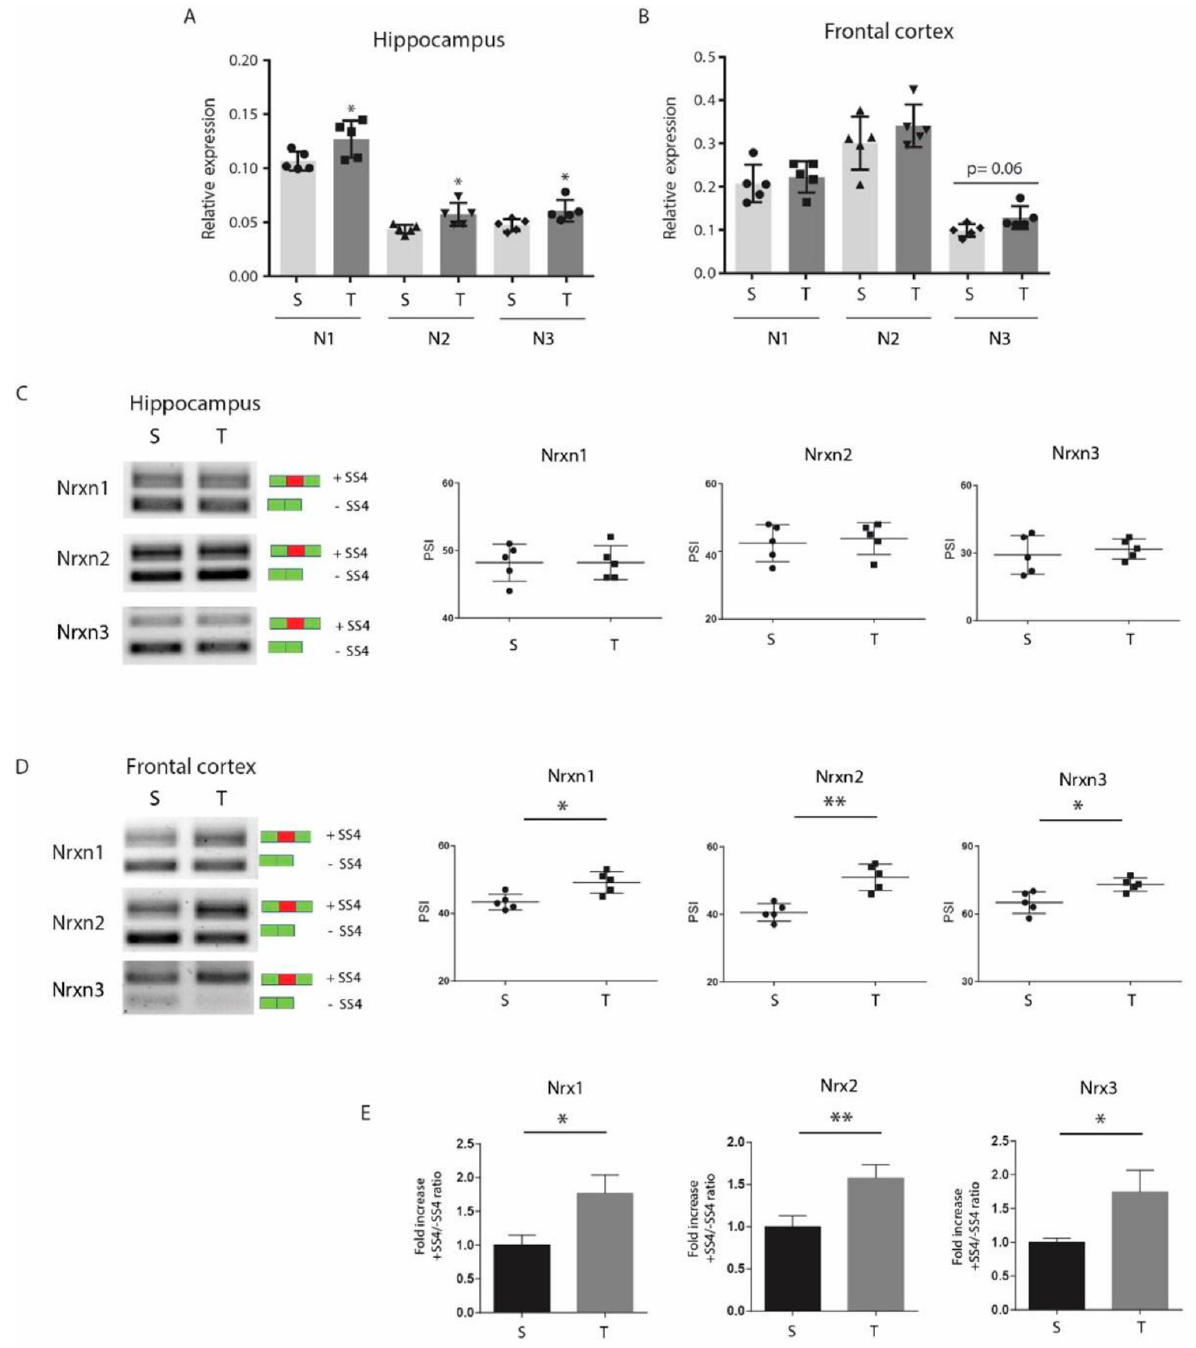
Figure 2. Effect of continuous progressive (CP) exercise on Nrxns splicing in frontal cortex (FC) and hippocampus. Histograms reporting gene expression analysis of total Nrxns (1–3) performed by RT-qPCR, using primers for a constant region, on cDNA from RNA extracted from ( A ) hippocampus and ( B ) FC of the sedentary and the CP-trained mice ( n = 5 per group). β -Actin is used as reference gene. The expression level of Nrxns increases in hippocampus but not